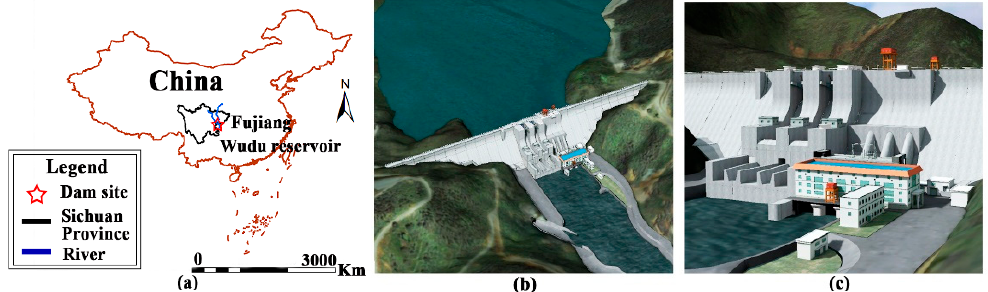
Figure 1. Wudu reservoir. ( a ) location of Wudu reservoir; ( b ) layout of the dam structures; ( c ) perspective view of the dam.